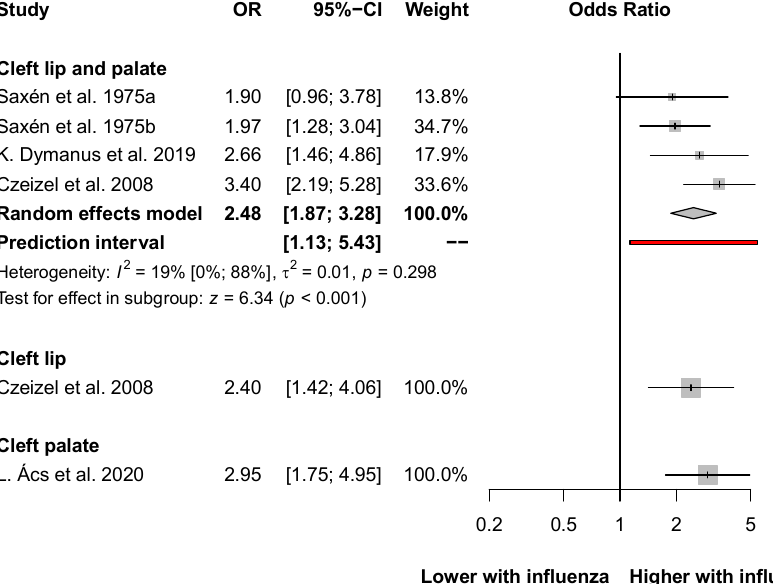
Figure 4. The odds of developing oral clefts after influenza infection in the first trimester [34,39– 41].